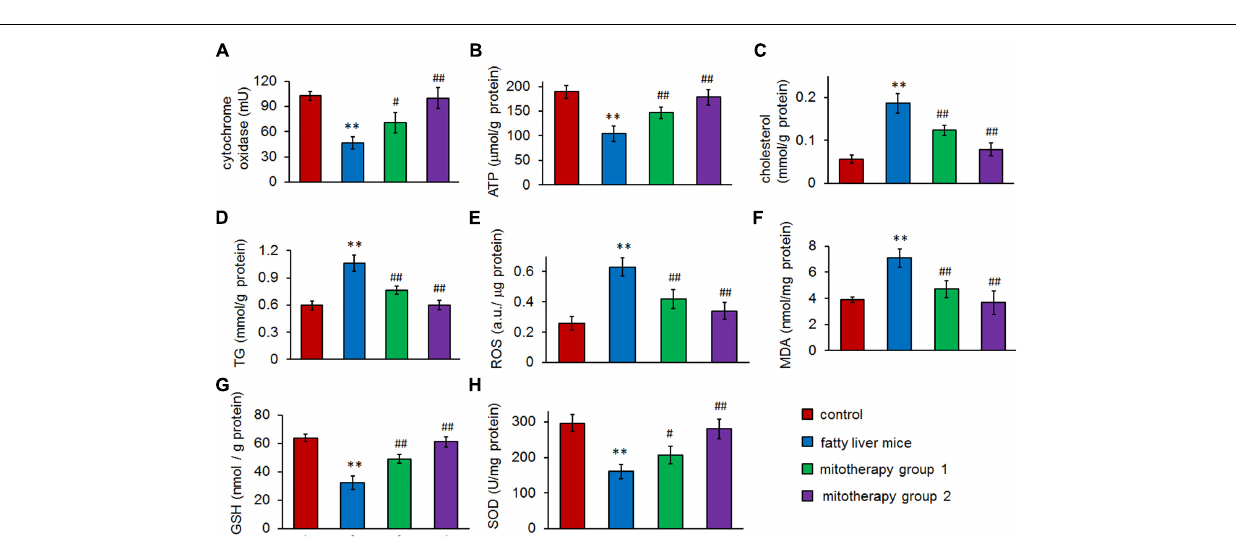
FIGURE 4 | Pathological changes of the liver tissues of the mice treated with high-fat diets and mitochondria. (A) Liver tissues were stained with Oil Red O. The excessive accumulation of lipid droplets in mouse liver appeared after the mice were fed with high-fat diet. Mice in mitotherapy group 1 were intravenously injected mitochondria three times in 9 days (once in 3 days), while mice in mitotherapy group 2 received mitochondria six times in 18 days. Representative photomicrographs (200 × ). (B) Ultrathin sections for mitochondrial observation under TEM. The red arrows pointed to normal mitochondria, while the blue ones pointed to the swelling mitochondria, and the yellow ones pointed to the restored mitochondria.